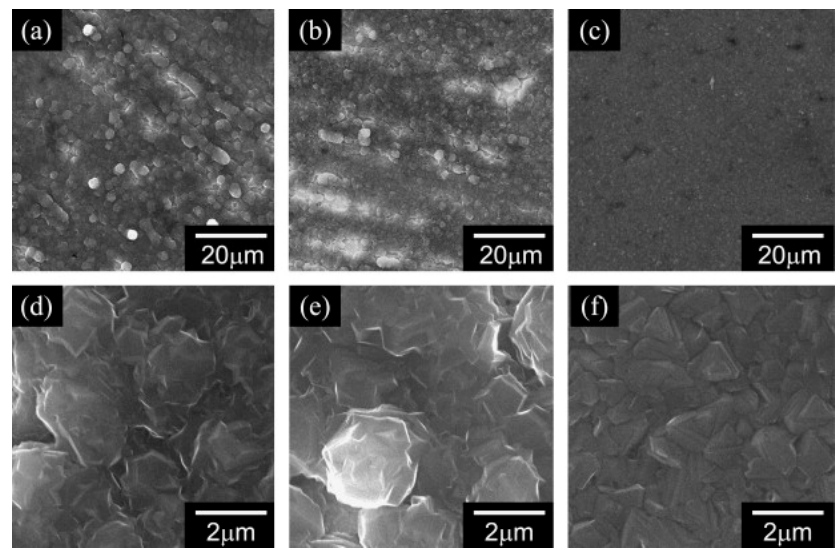
Figure 6. Scanning electron microscopy (SEM) micrographs of electrodeposited magnesium at different current densities: ( a ) 0.5 mA cm − 2 ; ( b ) 1.0 mA cm − 2 ; ( c ) 2.0 mA cm − 2 ; ( d ) 0.5 mA cm − 2 ; ( e ) 1.0 mA cm − 2 and ( f ) 2.0 mA cm − 2 . Adapted with permission from [146]. Copyright Elsevier B.V.,